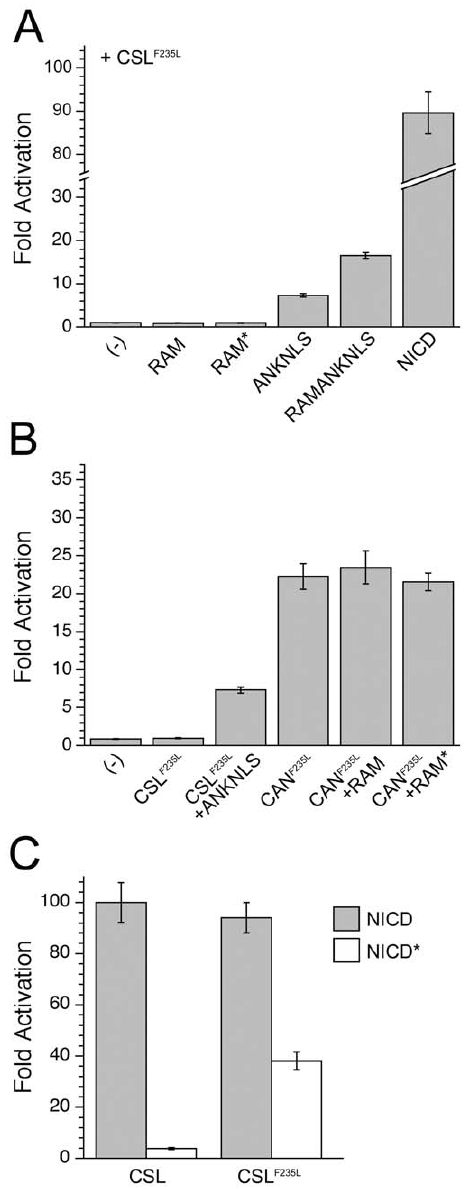
Figure 6. A Phe-to-Leu point-substitution fully activates the CAN fusion. A). In the context of CSL F235L , ANKNLS displays an increased level of transcriptional activity, though RAMANKNLS and NICD are largely unchanged, compared to wild-type CSL. B). Fusion of CSL F235L to ANKNLS (CAN F235L ) increases transcriptional activity by 3- fold compared to the co-transfection of CSL F235L and ANKNLS in trans , and renders the CAN F235L construct insensitive to further activation by RAM, unlike CAN (Figure 3C). This observation is consistent with the co- repressor perturbing effects of the F235L point substitution. C). The xWxP motif of RAM maintains interactions with F235L-substituted CSL. Mutation of the xWxP motif of RAM in full-length NICD (denoted NICD*) decreases transcriptional activity with co-transfected CSL from 100- to 4-fold. Mutation of the xWxP in full-length NICD decreases transcrip- tional activity with co-transfected CSL F235L from 94- to 38-fold, consistent with some level of interaction between the xWxP motif and CSL F235L . The increased output of NICD* in the presence of CSL F235L compared to wild-type CSL (38- vs. 4-fold, respectively) is presumably due to diminished co-repressor binding to CSL F235L